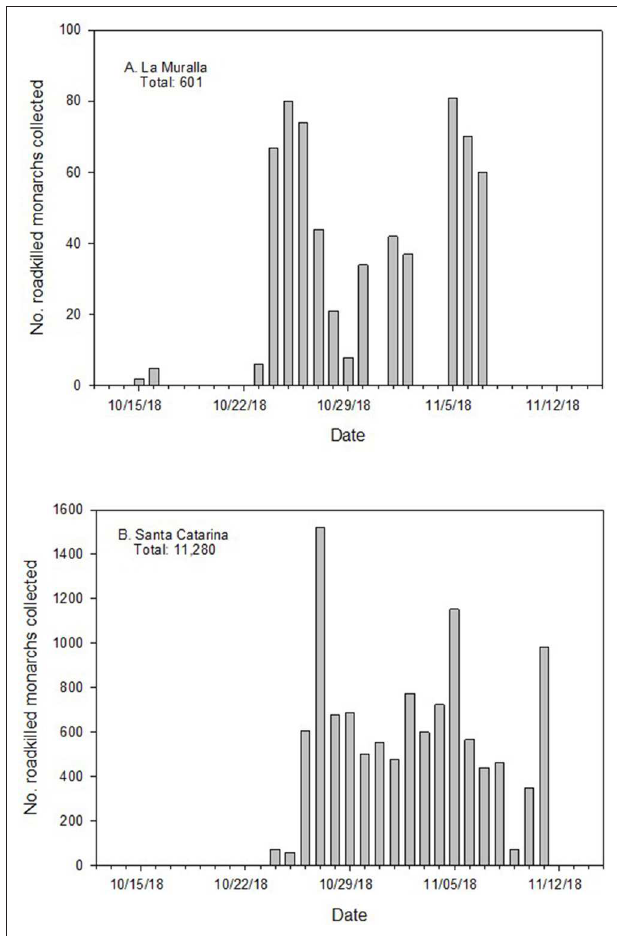
FIGURE 2 | Pattern of roadkilled monarchs collected during daily transects at (A) La Muralla (15 October − 7 November) and (B) Santa Catarina (24 October − 11 November). Days showing no monarchs collected within the sampling periods indicated were due to a halt in the